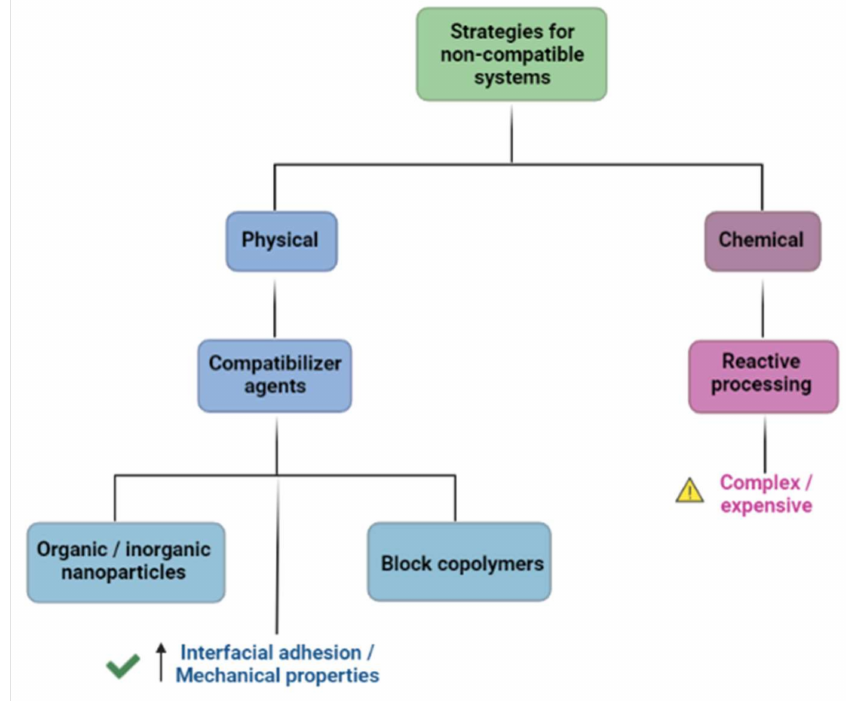
Figure 2. Schematic diagram of some strategies used to circumvent the outcomes of non-compatible systems.